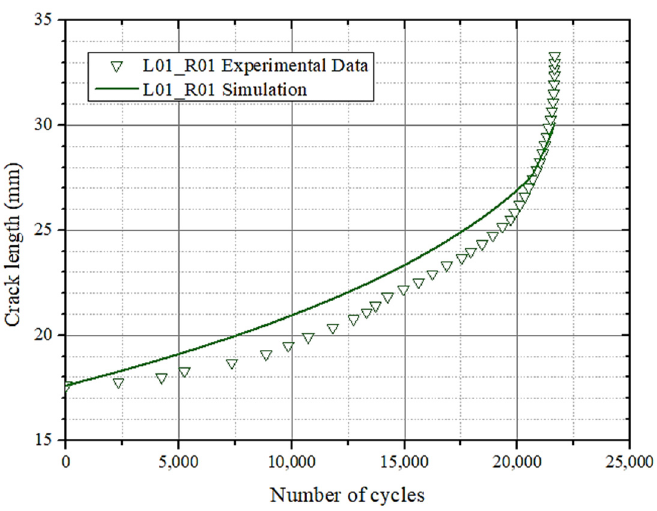
Figure 12. Crack length vs. number of cycles for L01-R01: experimental results and simulation. Table 1. Fitting parameters for the Paris model.